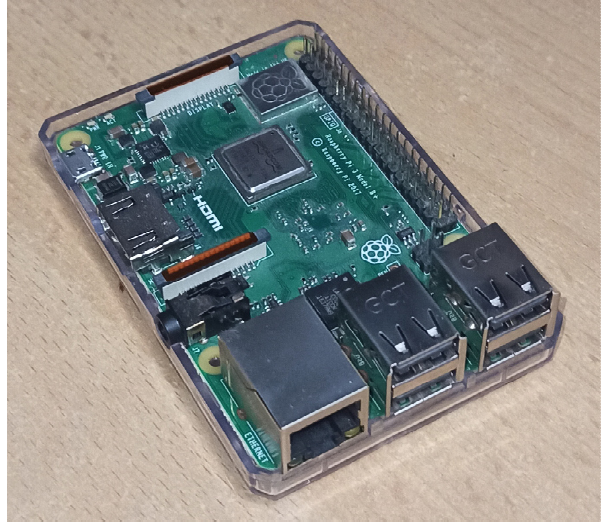
Figure 4. Raspberry pi 3 model B+ in a case, own study A. Wycisk.